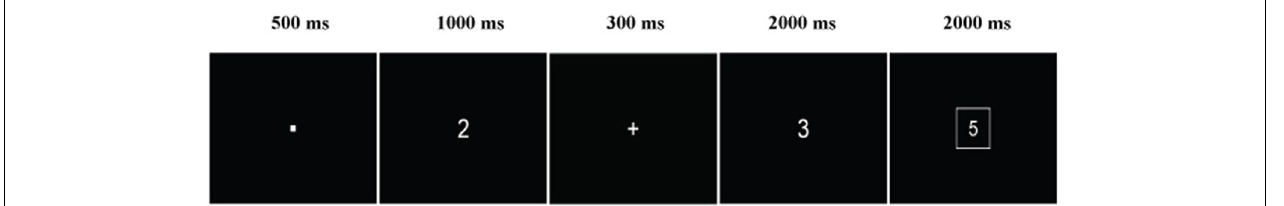
FIGURE 1 | Sample problem from the arithmetic verification